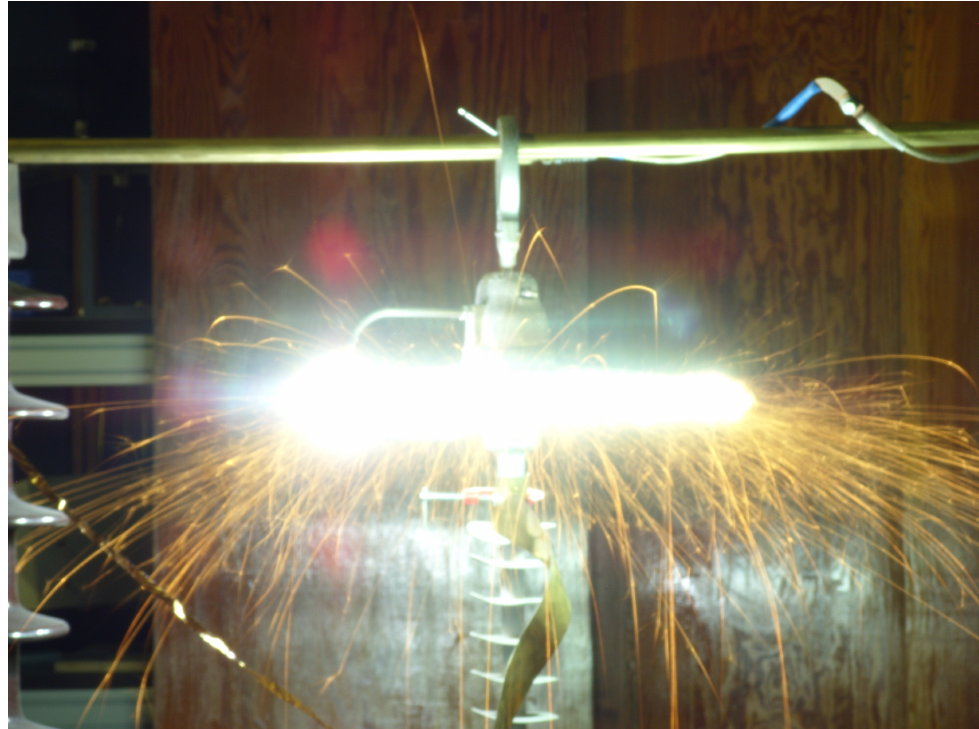
Figure 5. The development of the discharge along the MCA device as a result of applying a surge impulse